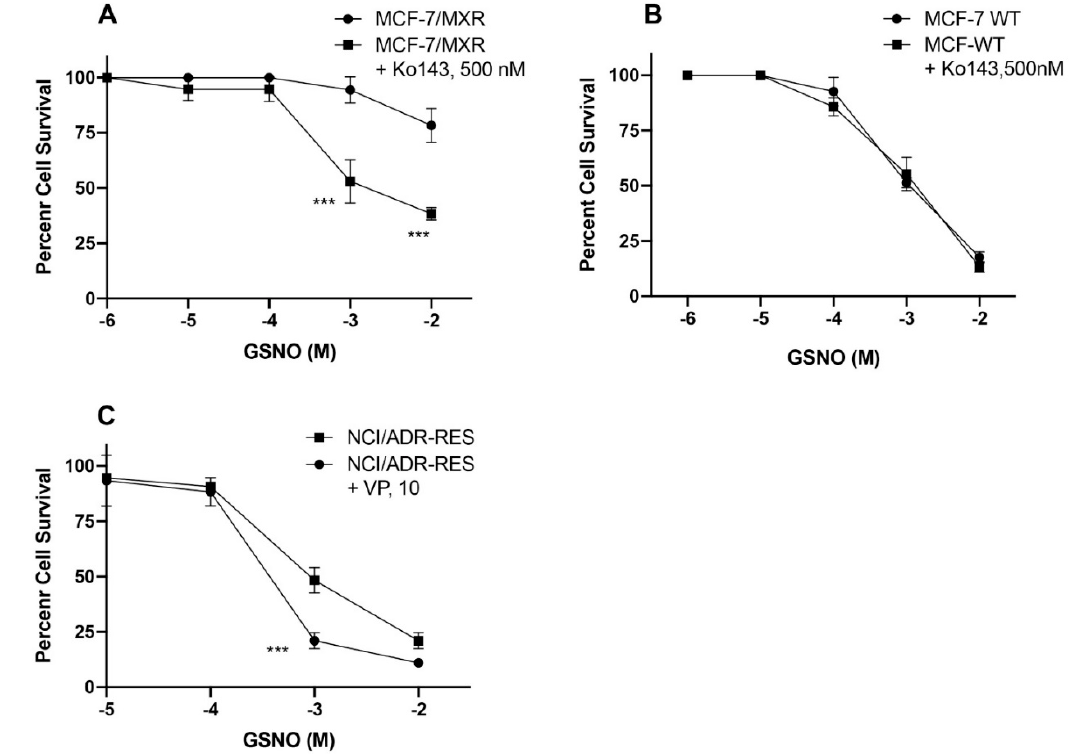
Figure 4. Cytotoxicity of GSNO in ( A ) MXR cells and ( B ) WT MCF-7 cells in the presence of 500 nm Ko143. Cytotoxicity of GSNO in ( C ) NCI/ADR-RES cells in the presence of Verapamil (10 µM). Ko143 or Verapamil was preincubated with cells for 2h in the complete medium before adding various concentrations of GSNO as detailed in the methods section. *** p values < 0.001 compared with concentration-matched samples.